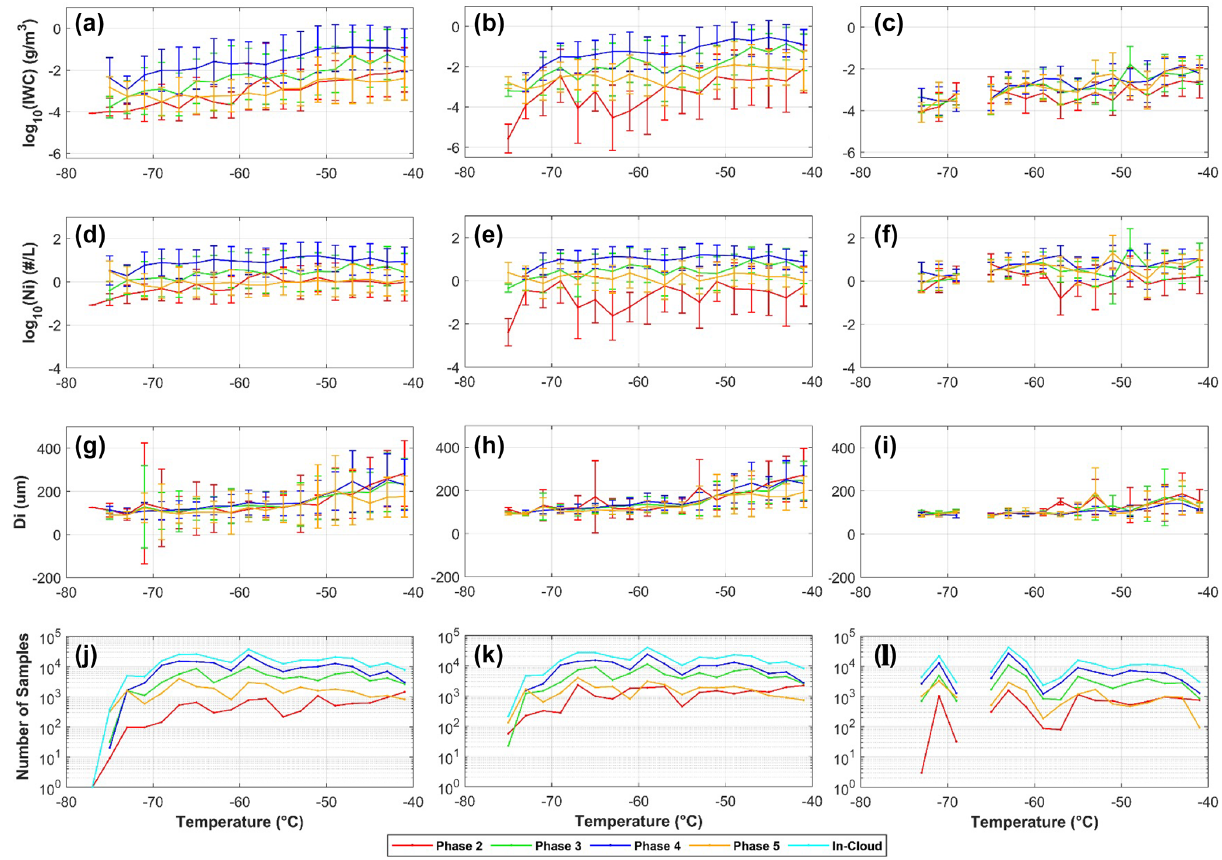
Figure 7. Averages of log 10 (IWC), log 10 (Ni) and Di in each 2 ◦ temperature bin for evolution phases 2 to 5 using 1s observations, obser- vations averaged to a 100km horizontal scale, and the simulations in columns 1, 2 and 3, respectively. The number of samples is shown in the last row. In Figs. 7–11 and 14–17, only NSF campaigns are used for comparisons with model simulations since the NSF and NASA campaigns used cloud probes with different measurement